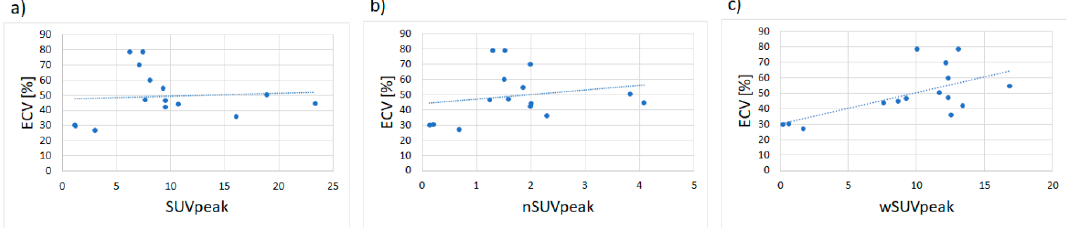
Figure 4. Correlation of SUVpeak, nSUVpeak and wSUVpeak with ECV: ( a ) and ( b ) SUVpeak, nSUVpeak showed no correlation with ECV (r = 0.07; p = 0.81 and r = 0.20; p = 0.48); ( c ) while wSUVpeak showed a good correlation with ECV (r = 0.61; p = 0.015).